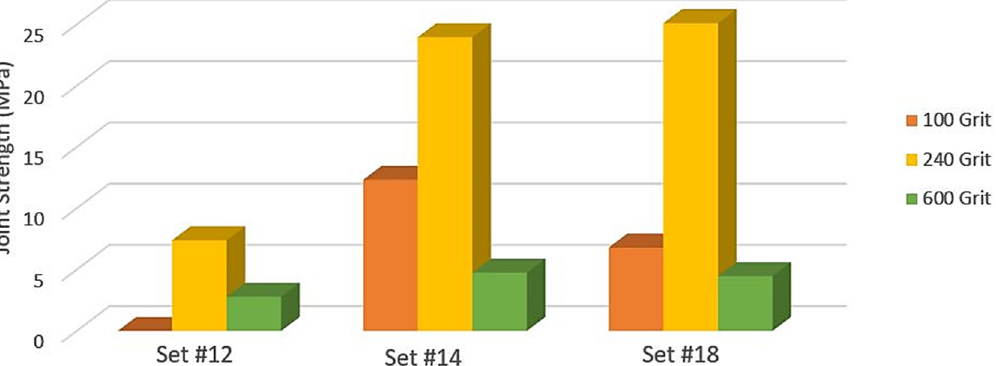
Figure 10. The influence of the size of abrasive materials employed on the surface mechanical pre-treatment on the joint strength for three sets of laser welding parameters.